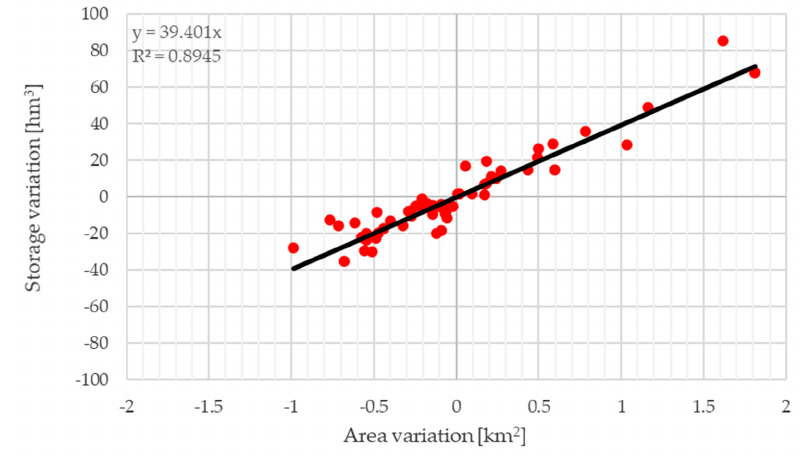
Figure 6. Scatter plot of area–storage variation pairs.